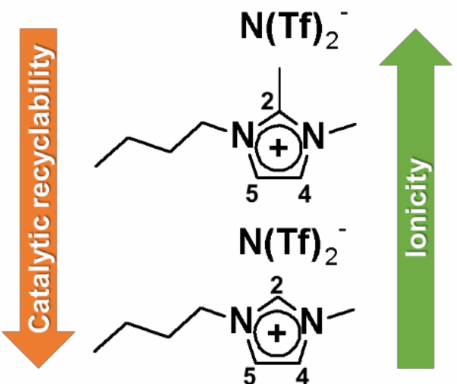
Figure 41. The relationship between imidazolium cations ionicity and ruthenium nanoparticles (NPs) recyclability observed after hydrogenation reactions performed with ruthenium embedded in two imidazolium ILs.